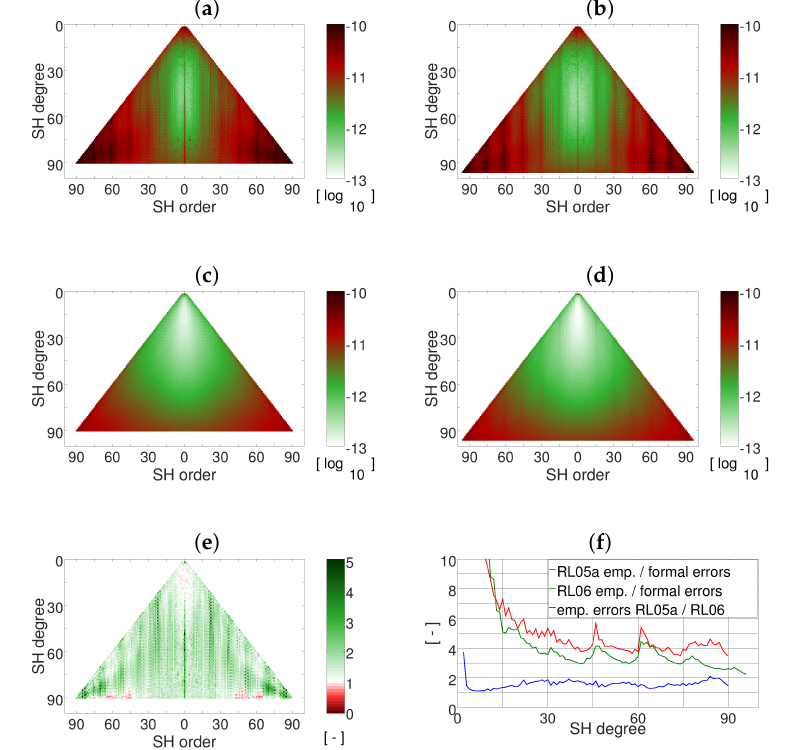
Figure 3. ( a – d ) SH spectra of empirical error RMS for RL05a ( a ) and RL06 ( b ); and of formal error RMS for RL05a ( c ) and RL06 ( d ); ( e ) Ratio of SH spectra of empirical error RMS “RL05a/RL06”; ( f ) SH degree amplitudes of the ratio of empirical error RMS “RL05a/RL06” (blue), and the ratios “empirical/formal error RMS” for RL05a (red), and RL06